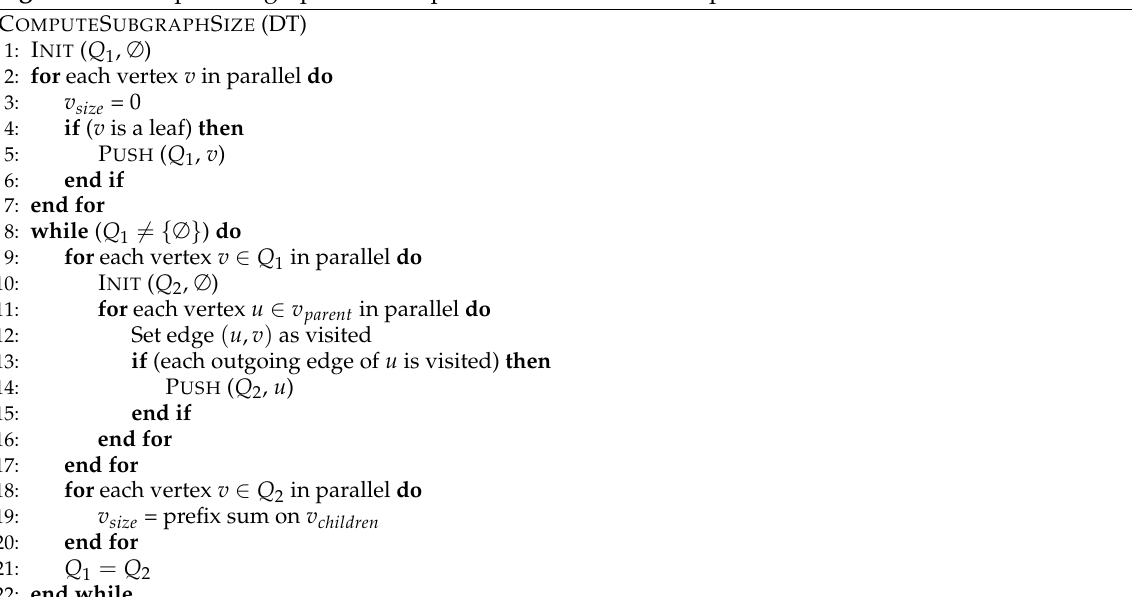
Algorithm 4 Step 2: Subgraph size computation with a bottom-up